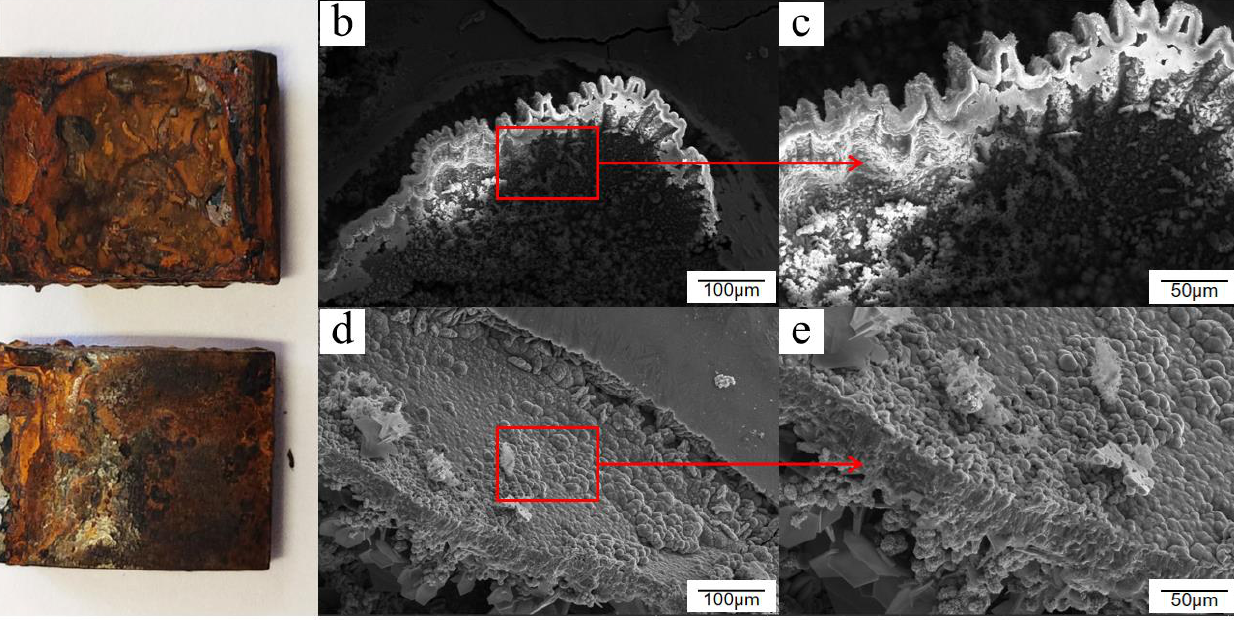
Figure 8. Macroscopic and microscopic morphology of Q235 low-carbon steel after 16 days of exposure in the cyclic salt spray accelerated corrosion test: ( a ) macroscopic appearance, ( b ) corrosion layer folds, ( c ) enlarged drawing, ( d ) corrosion product stacking up, and ( e ) enlarged drawing.